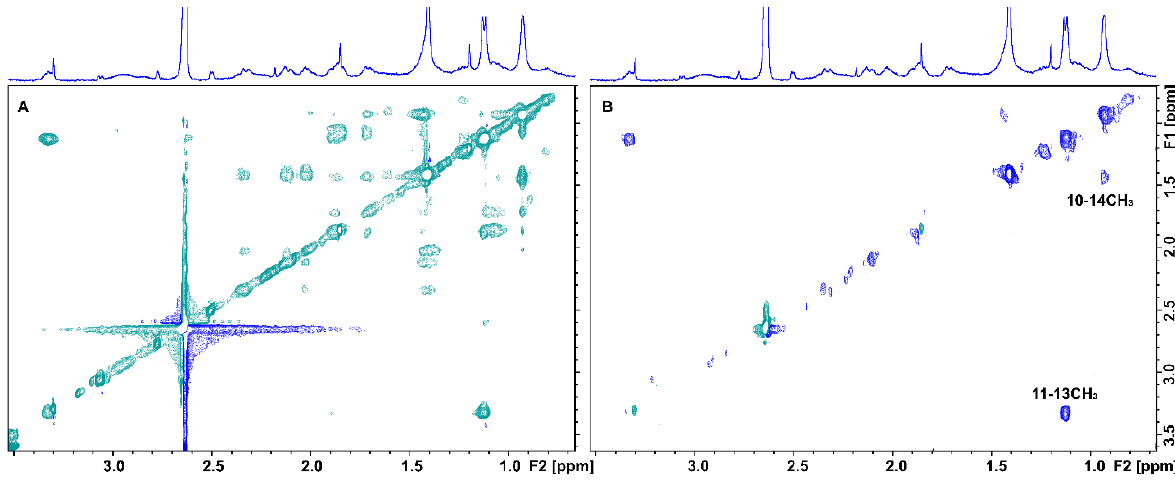
Figure 2. ( A ) 2D TOCSY NMR of 2 mM artemisinin and 20 μM BSA in PBS, pD 7.4, D 2 O with 10% DMSO-d 6 . ( B ) 2D STD-TOCSY NMR of 2 mM artemisinin with 20 μM BSA in PBS, pD 7.4, D 2 O